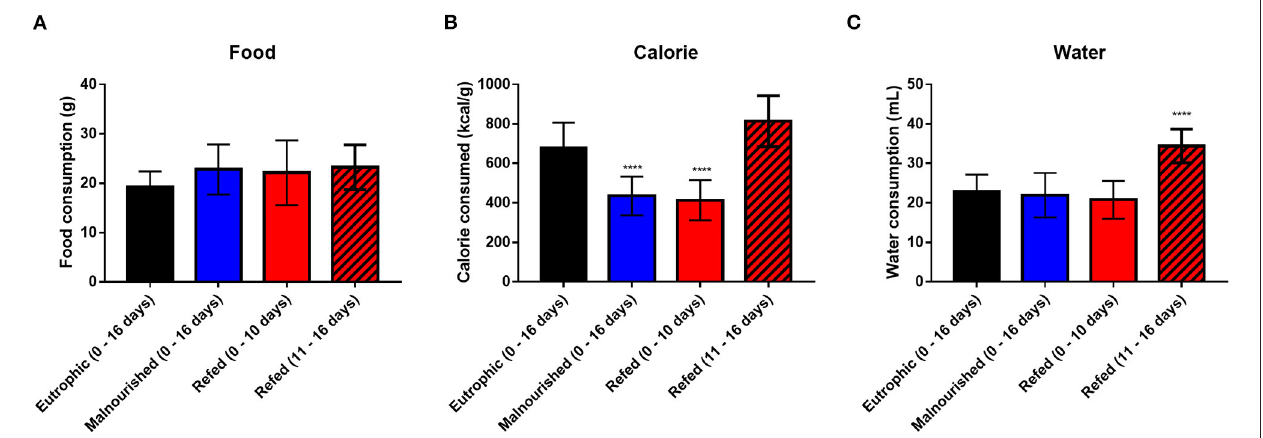
FIGURE 4 | Average consumption of water, food and calories. Daily consumption of food (A) ; calories (B) ; and water (C) . The values represent measurements from day 0 to day 16 in control and malnourished mice and from day 0 to day 10 and from day 11 to day 16 in refed mice. Black: control group; blue: malnourished group; red: refed group between days 0 and 10; striped red: refed group between days 11 and 16. **** p < 0.0001. (*) Represent differences compared to control mice. The values are represented by the mean ± standard error of three independent experiments with 15 animals in each group.